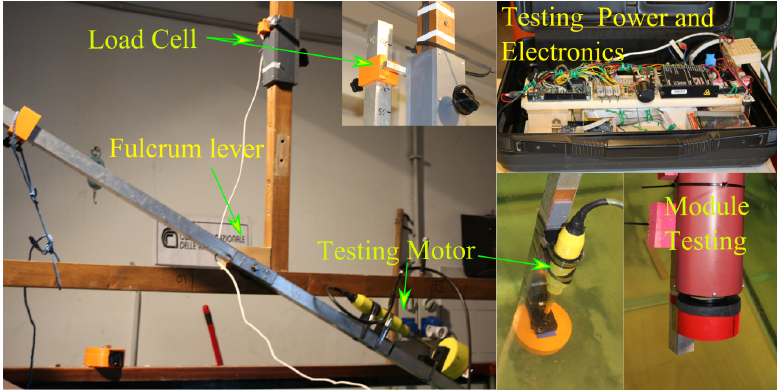
Figure 15. The fulcrum lever